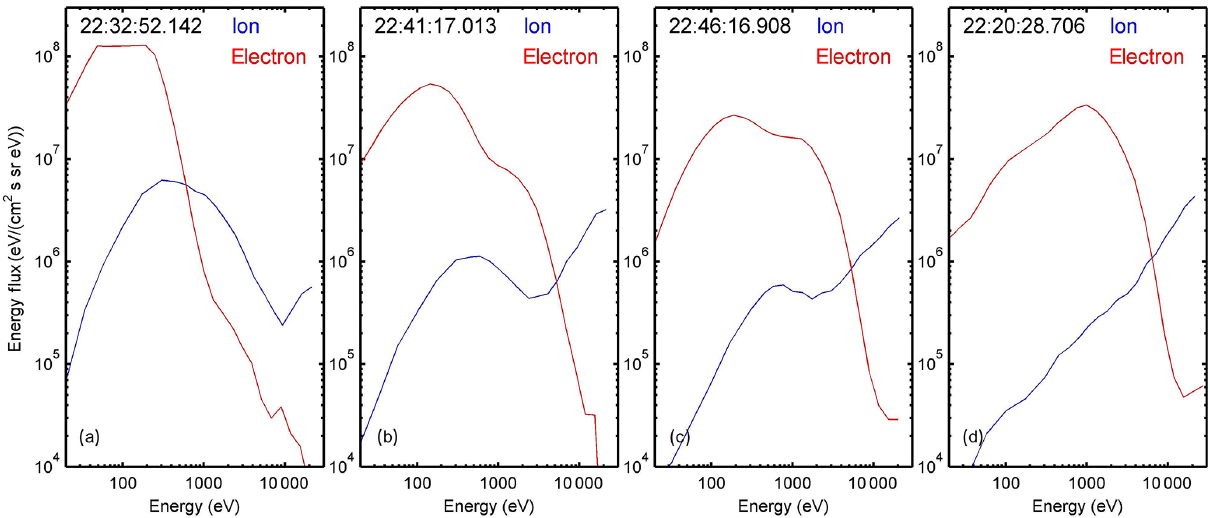
Figure 6. Typical portraits of the energy–time spectra of plasmas in different regions. Panel (a) is the magnetosheath observed by TH-A at 22:32:52.142; panel (b) is coexistence region I observed by TH-A at 22:41:17.013; panel (c) is coexistence region II observed by TH-E at 22:46:16.908; panel (d) is the magnetosphere observed by TH-A at